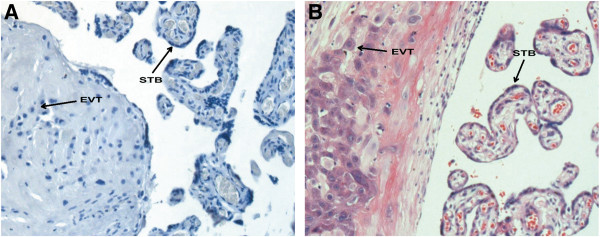
The PBS staining and the H&E staining of placental tissue sections. Figure 
2A shows the PBS staining as negative control, Figure 
2B shows the H&E staining. STB = syncytiotrophoblast, EVT = extravillous trophoblast. Original magnification: 200× for A and B.